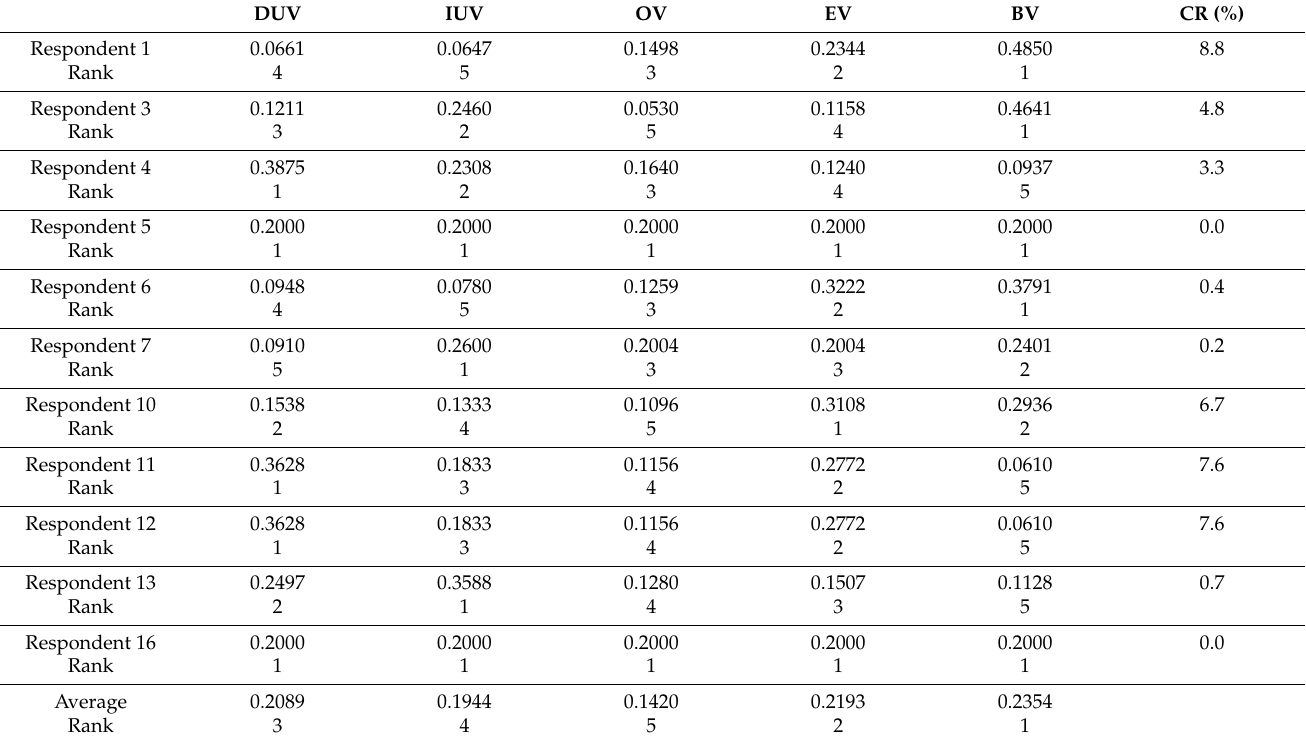
Table A3. Weighted coefficient related to TEV